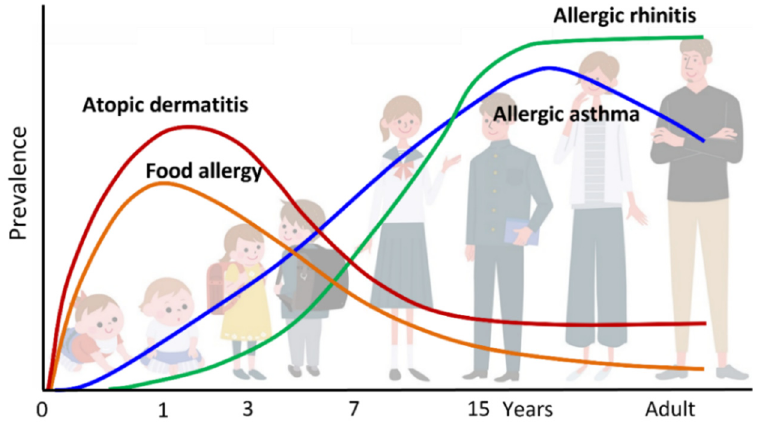
Figure 1. Atopic march. Atopic dermatitis (AD) generally develops first, followed by IgE-mediated food allergy (FA), allergic asthma (AA), and allergic rhinitis (AR). Development of FA, AA, and AR correlates with AD severity in infancy.